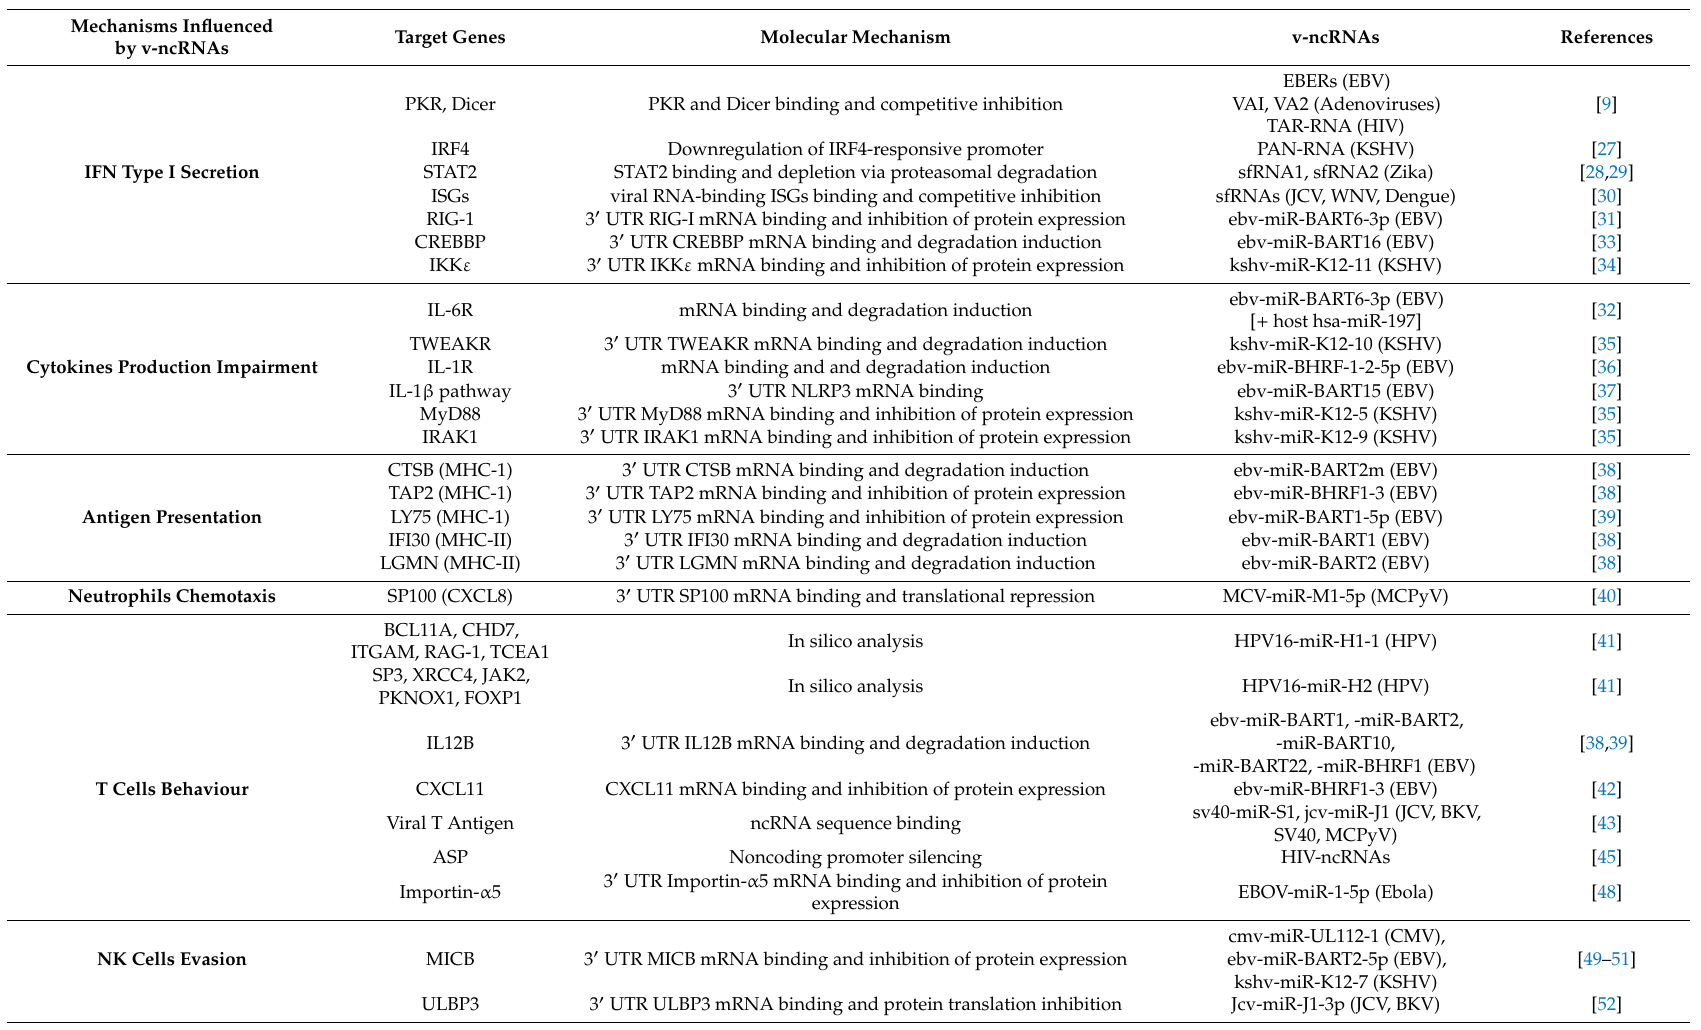
Table 1. Currently known immune mec‘anisms and target genes influenced by